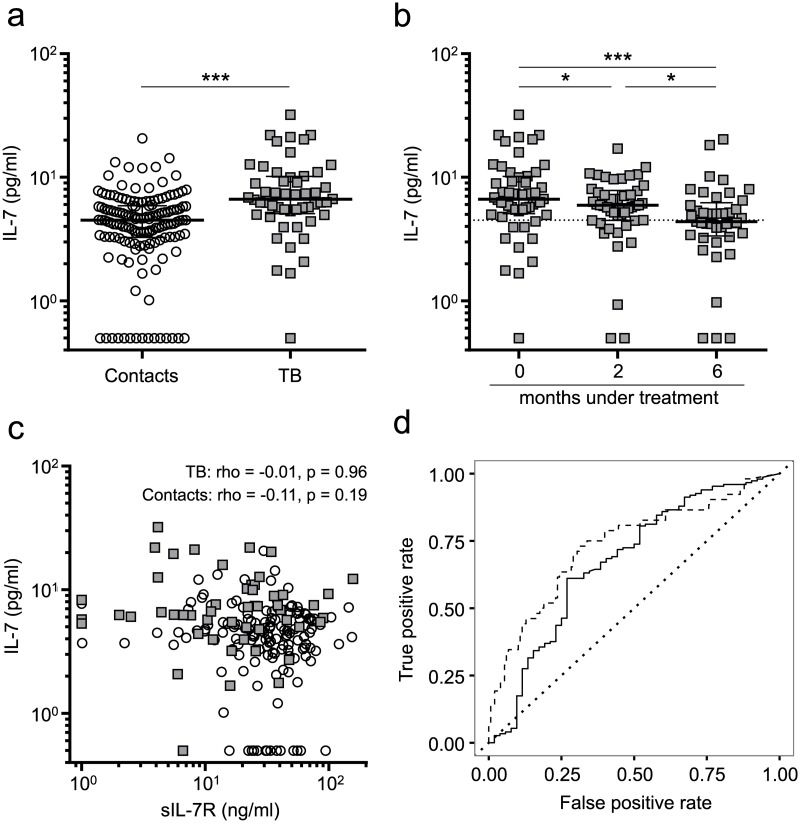
Plasma IL-7 concentration of tuberculosis patients and healthy contacts.(a) Comparison of IL-7 plasma concentrations between tuberculosis patients (n = 52) and healthy contacts (n = 148). (b) Plasma IL-7 concentrations prior to (0 months, n = 52), during (2 months, n = 46), and after (6 months, n = 41) treatment of tuberculosis patients. Median IL-7 plasma level of healthy contacts is represented with a dotted line. (c) Spearman correlation between plasma IL-7 and sIL-7R for tuberculosis patients prior to treatment (squares), and healthy contacts (circles). (d) Receiver operating characteristic (ROC) curve indicates sensitivity and specificity of plasma sIL-7R (solid line) and plasma IL-7 (dashed line) to discriminate between patients with tuberculosis and healthy contacts. The line of no discrimination is indicated as a dotted line. Median and interquartile range is depicted, and each symbol indicates mean values of duplicates from each individual donor. Exact Mann-Whitney U test was used for comparison of groups, whereas paired data was evaluated by Wilcoxon Signed-Rank test. Nominal p-values are indicated as: * p < 0.05, *** p < 0.001.